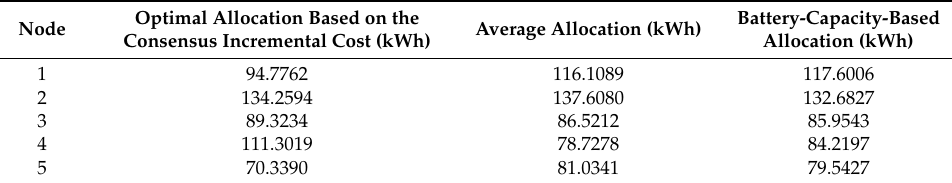
Table 5. The energy information of each node under different allocation methods.